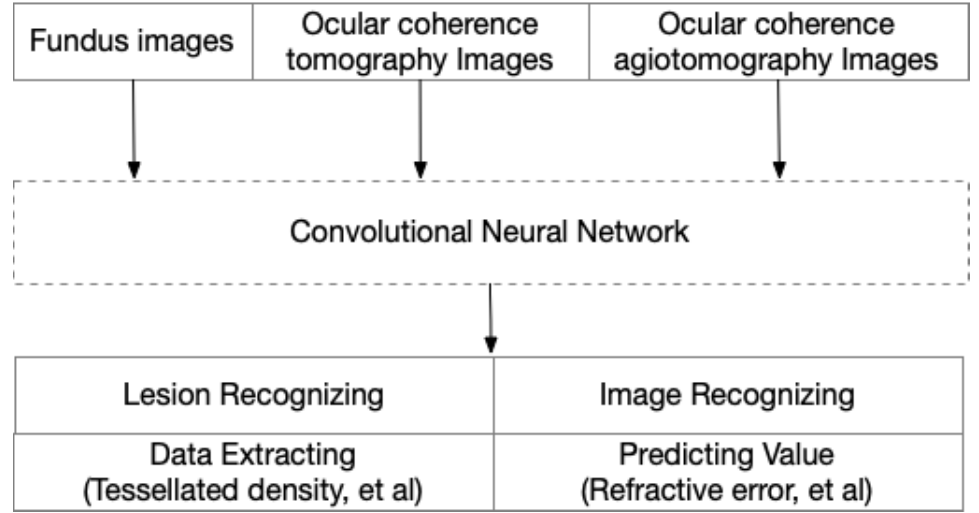
Figure 4. Image-driven artificial intelligence in high myopia and pathologic myopia .